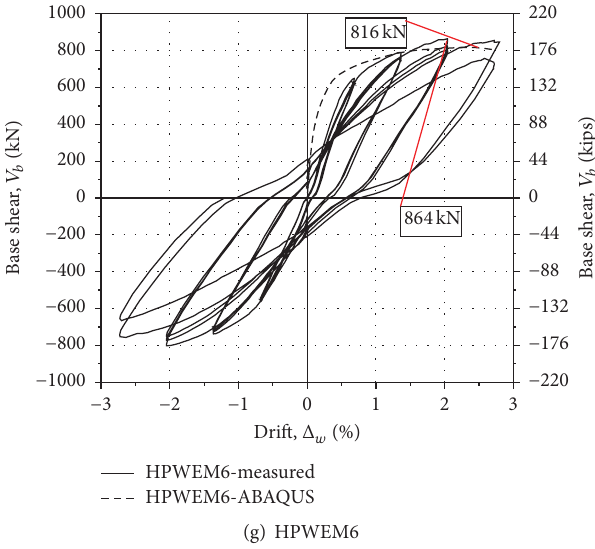
Figure 8: Hysteretic curves.